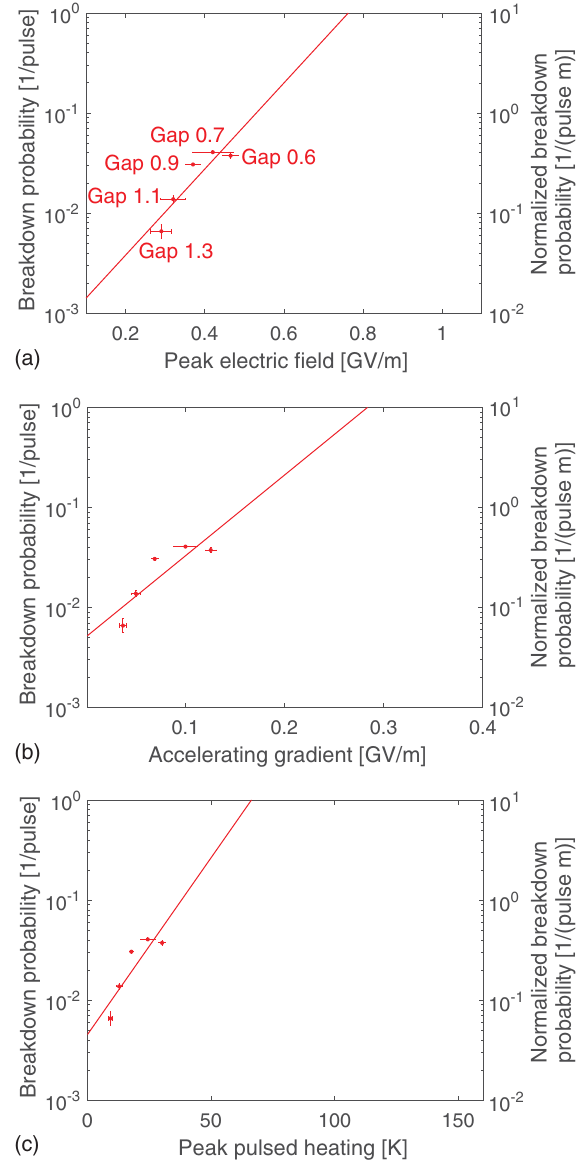
FIG. 24. Constant gradient breakdown rate measurements, obtained by placing the electron beam in the central axis of the copper-silver structure, with 1.6 nC of bunch charge and σ ¼ 25 μ m, as a function of the peak electric field (a), as a z function of the accelerating gradient (b), and as a function of the peak pulsed heating (c). The repetition rate was 29